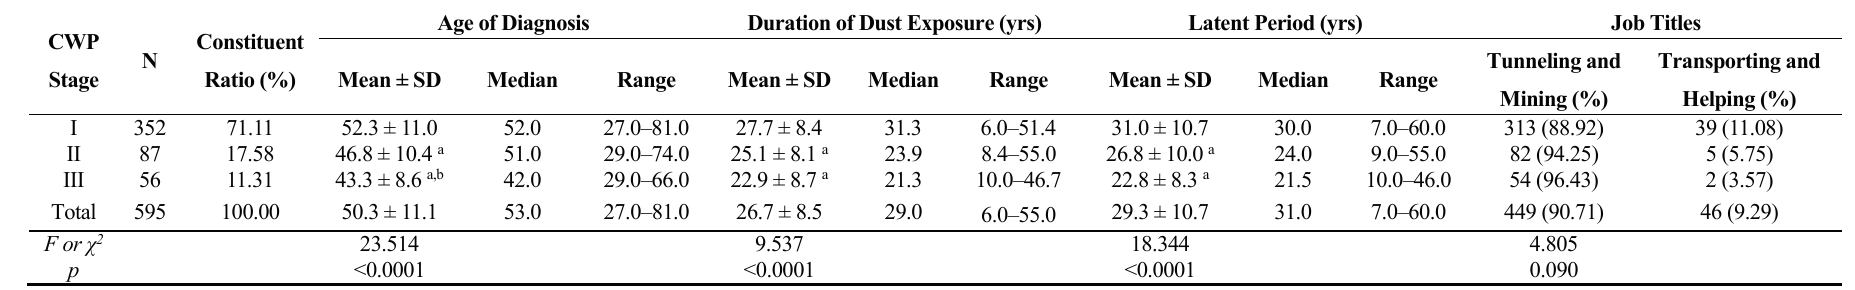
Table 1. The distributions of age of diagnosis, duration of dust exposure, latent period and job titles in different stages of CWP. CWP